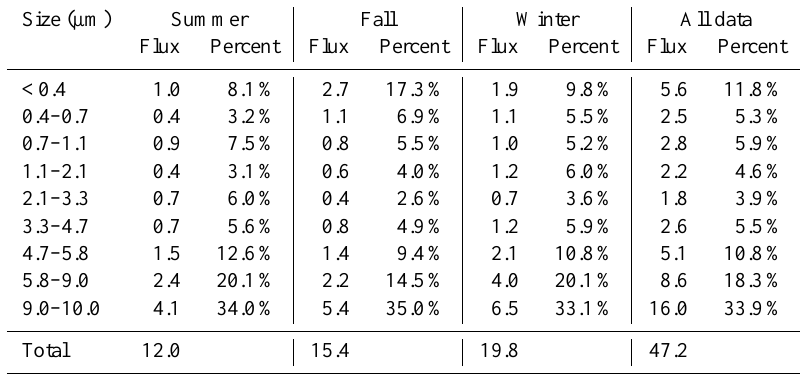
Table 4. Dry deposition fluxes (µgm − 2 ) in each size fraction and in each season. Size